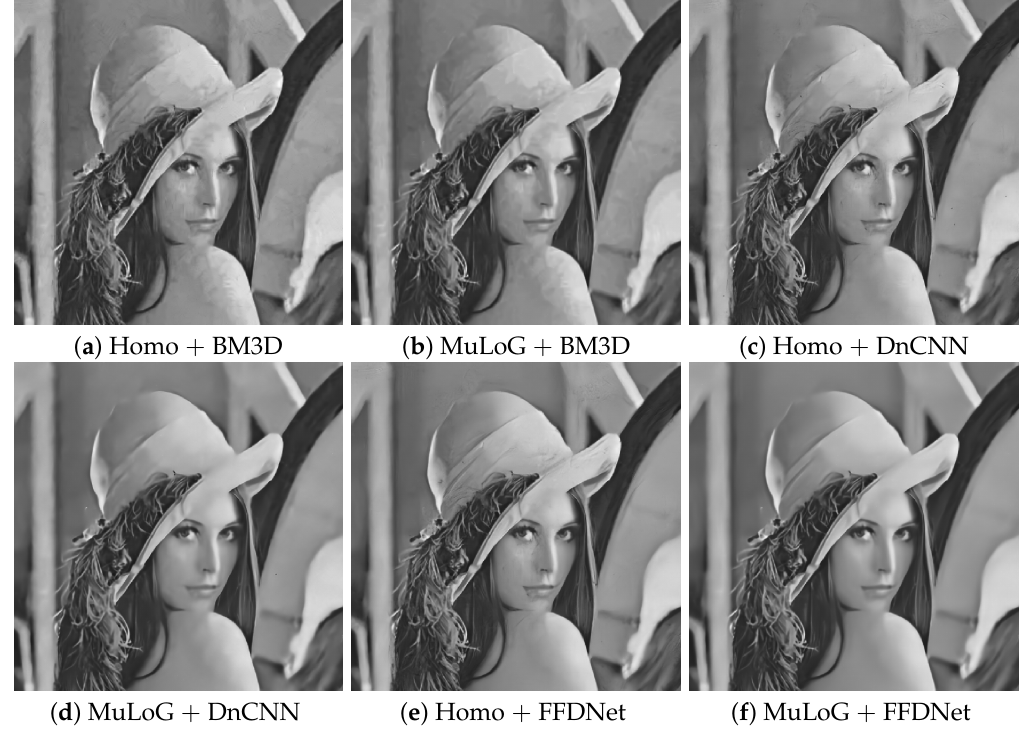
Figure 7. The denoising results for simulated SAR image with L = 4: ( a – f ) Homo + BM3D, MuLoG + BM3D, Homo + DnCNN, MuLoG + DnCNN, Homo + FFDNet, and MuLoG + FFDNet,